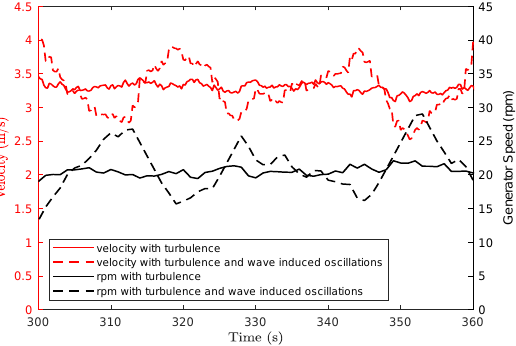
Figure 16. Active speed stall control of generator speed as a function of change in tidal stream velocity. Mean tidal velocity in this image is set at 3.3 m/s